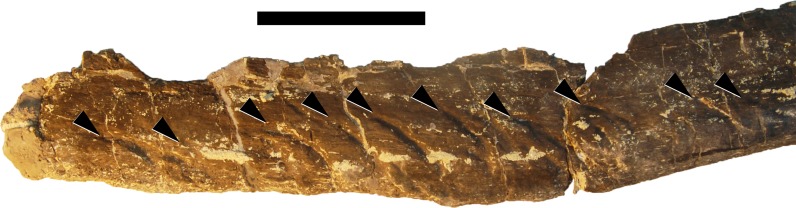
Bite marks on the left dorsal rib 2.The bite marks (arrowheads) occur on the distal end of DR 2, shown in lateral view. Scale bar = 5 cm.